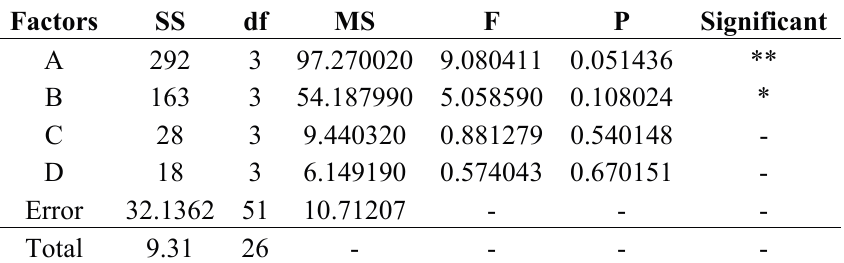
Table 3. Variance analysis of orthogonal